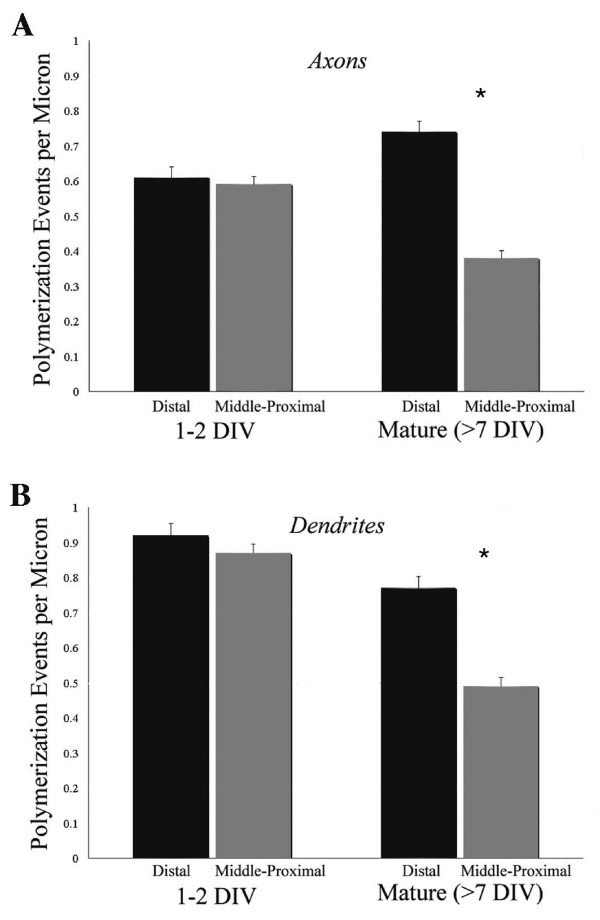
The spatial distribution of microtubule polymerization becomes biased towards distal regions as axons and dendrites develop. (A, B) The mean number of comets per micron was determined within segments representing the proximal-middle versus distal region (excluding the growth cone) of axons (A) and dendrites (B). For both axons and dendrites, microtubule polymerization was distributed equally within all regions at the earliest stages of development, but predominated within distal segment as neurons matured. Error bars represent standard error of the mean; P < 0.0001.